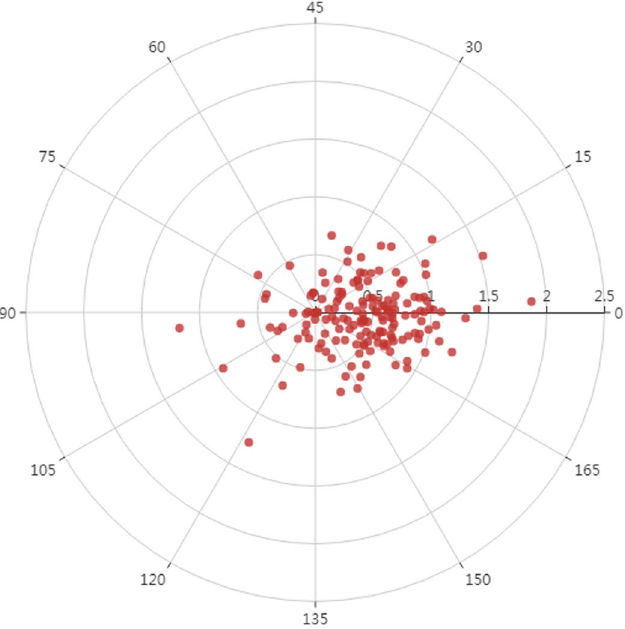
Figure 3. The distribution of ORA obtained in the refractive astigmatism eyes on double angle vector